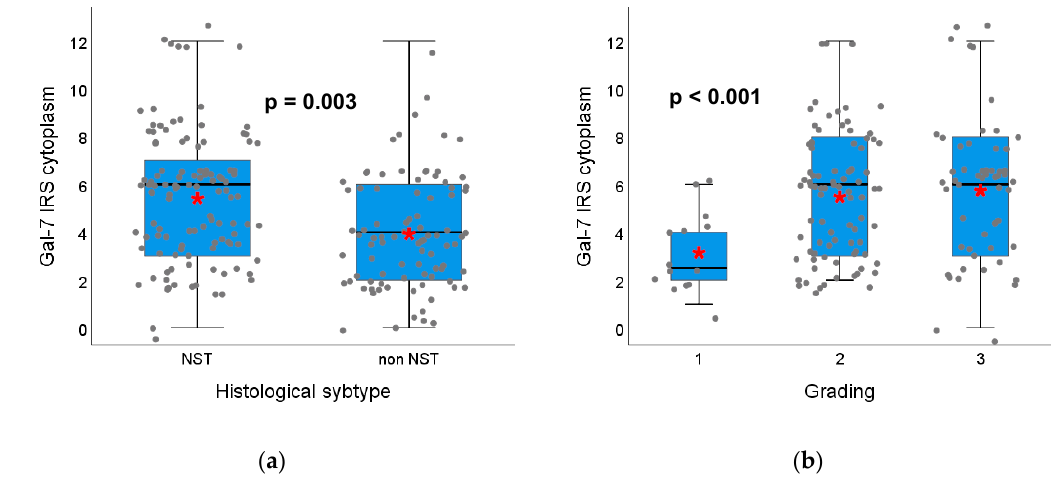
Figure 1. Association of Gal-7 expression with histological subtype and tumor grading. Boxplots of the median IRS of Gal-7 staining in the cytoplasm dependent on histological subtype ( a ) and tumor grading ( b ) of the tumor are shown. ( a ) In non-NST tumors, Gal-7 expression in the cytoplasm is significantly lower than in NST tumors. ( b ) Tumors with G2 / 3 grading show a significantly higher Gal-7 expression in the cytoplasm compared to G1 tumors. Red asterisks indicate means. Please note that individual datapoints have been jittered to avoid overlap.